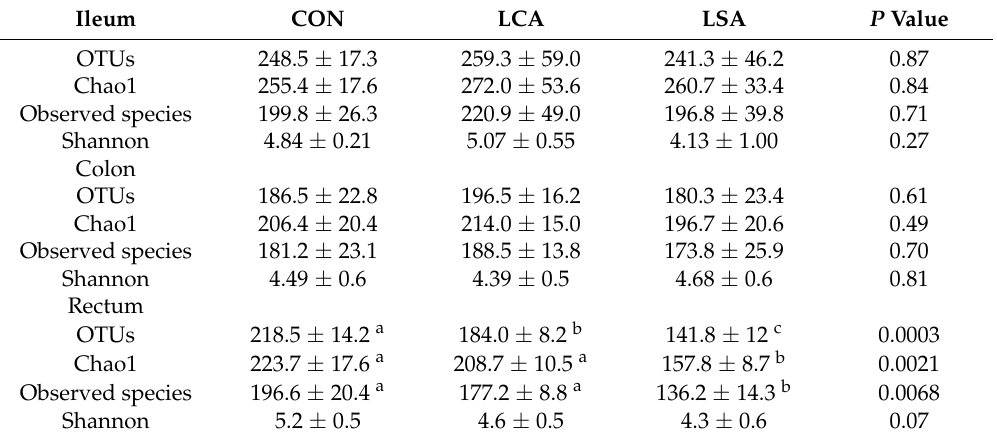
Table 2. The effect of low amount of antibiotics on operational taxonomic units (OTUs) and alpha diversity for ileum, colon and